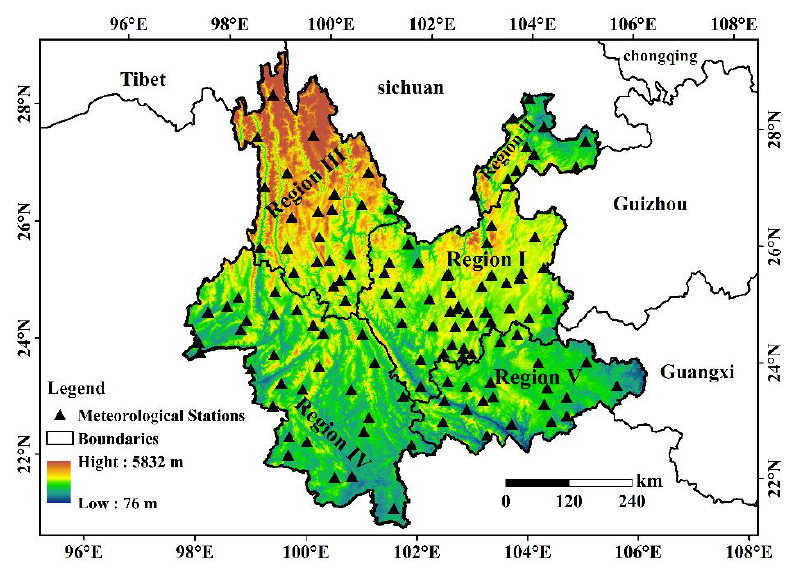
Figure 1. Distribution of meteorological stations and terrain features in Yunnan, China. Notes: Region I–IV represent central, northeast, northwest, southwest, and southeast Yunnan, respectively.